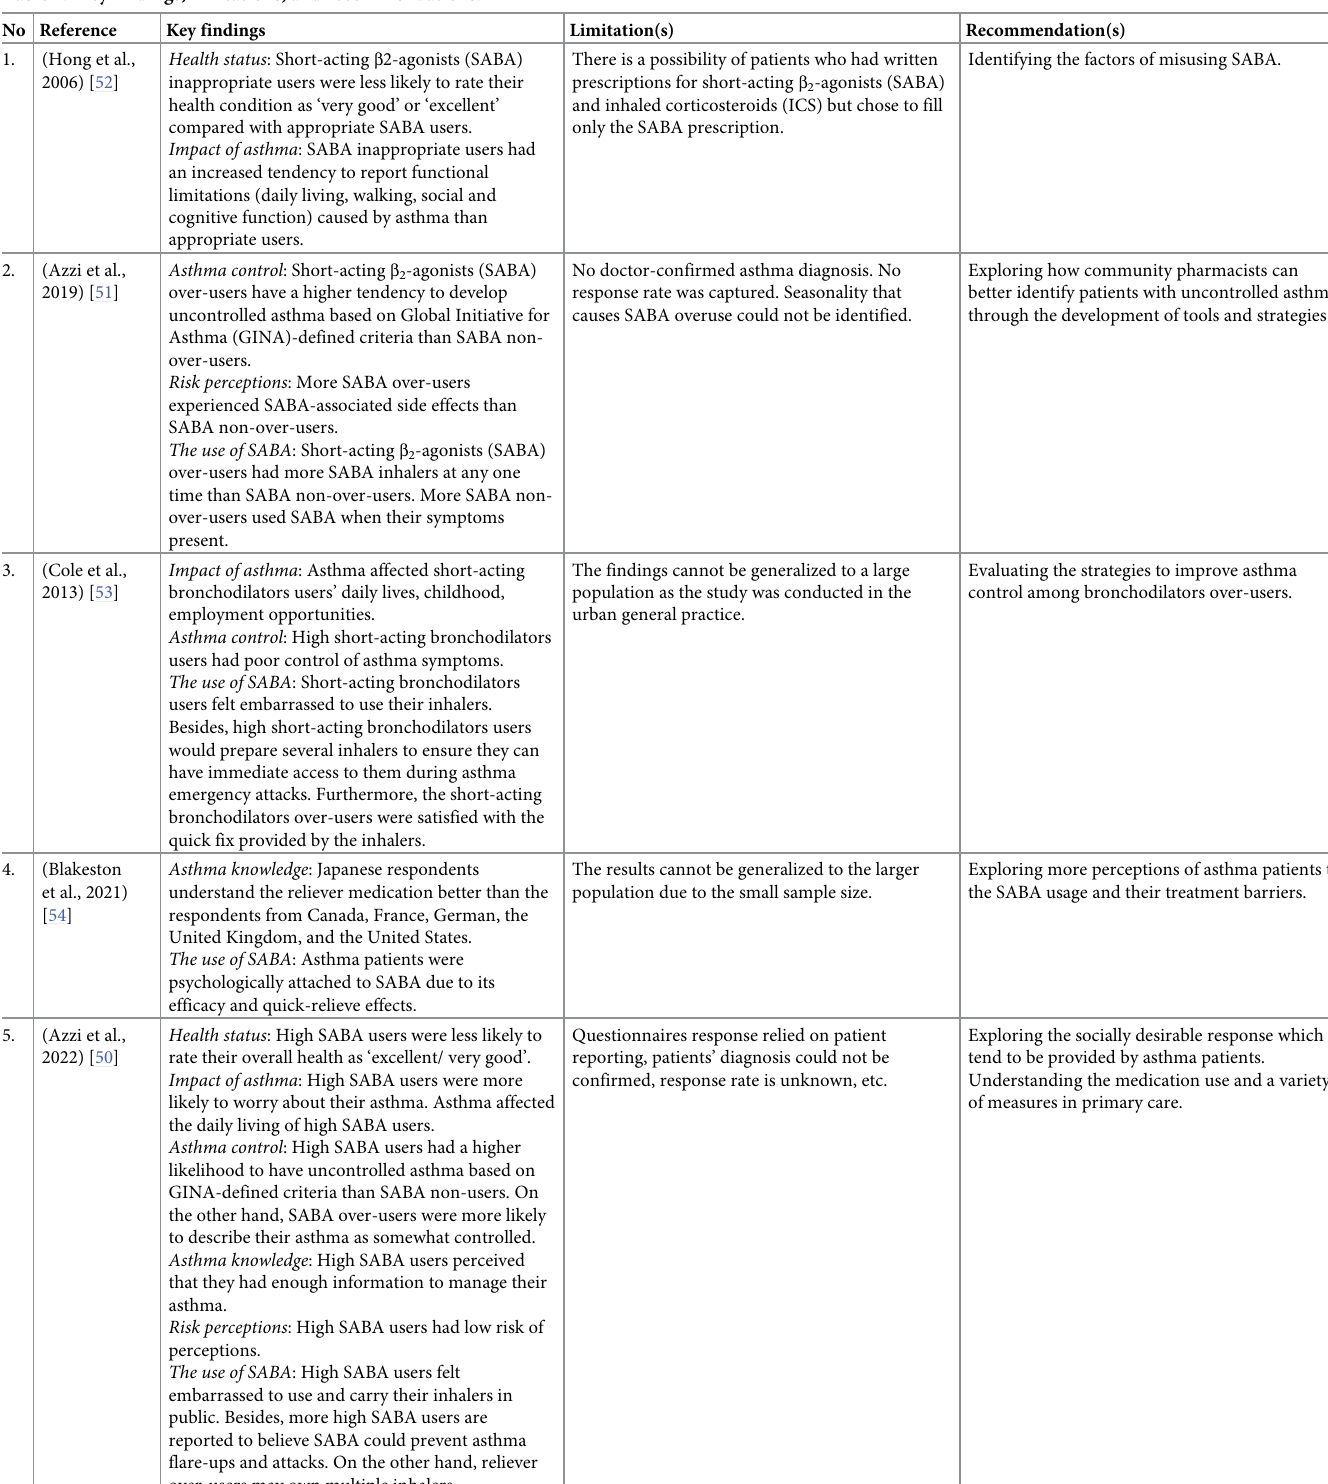
Table 2. Key findings, limitations, and